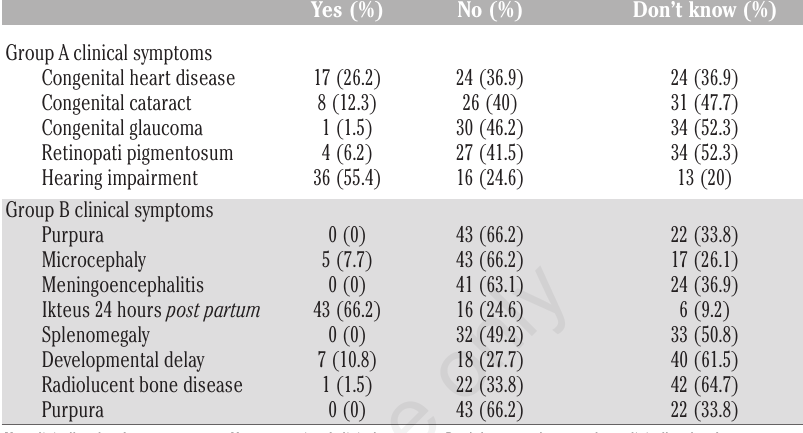
Table 1. Clinical symptoms of CRS.